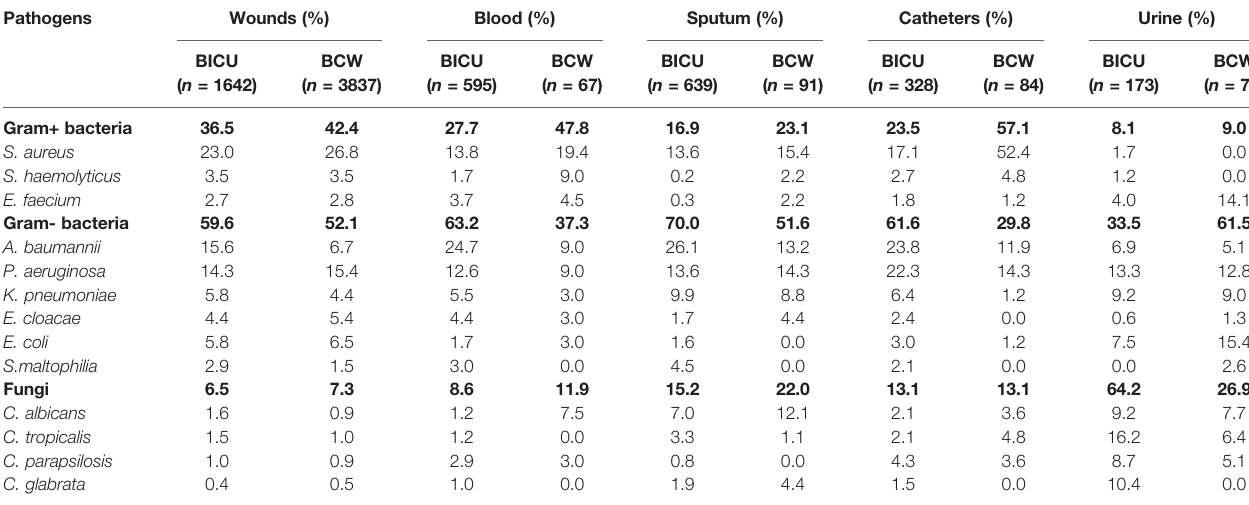
TABLE 2 | Pathogen distributions among different types of clinical samples.